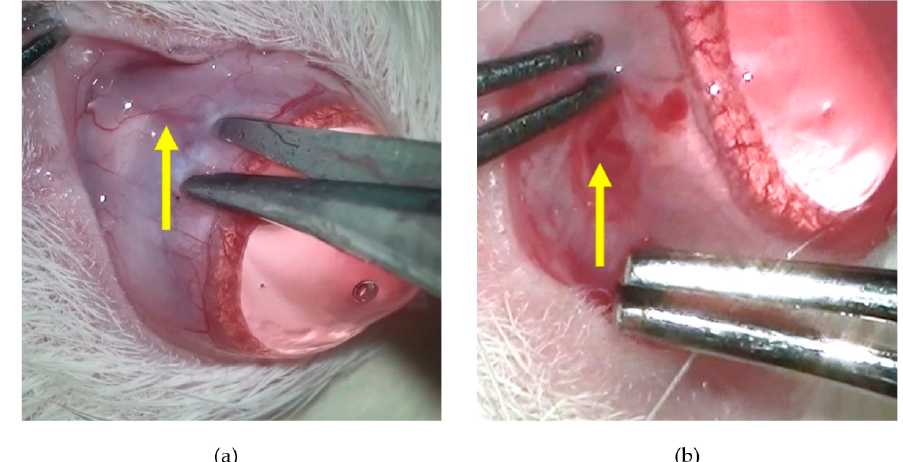
Figure 9. Photo of a rat ocular globe during the microsurgical procedure: ( a ) yellow arrow indicates a dorsal episcleral vein before conjunctiva incision; ( b ) yellow arrow indicates a lateral episcleral vein after the conjunctival incision.